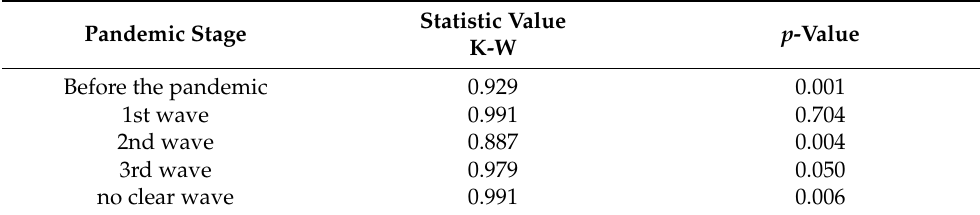
Table 3. The results of the goodness of fit of the empirical